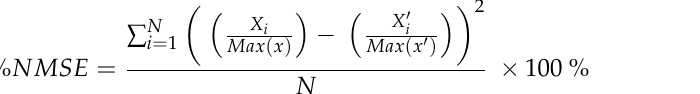
Figure 11. Stator current for healthy and 19% eccentricity.